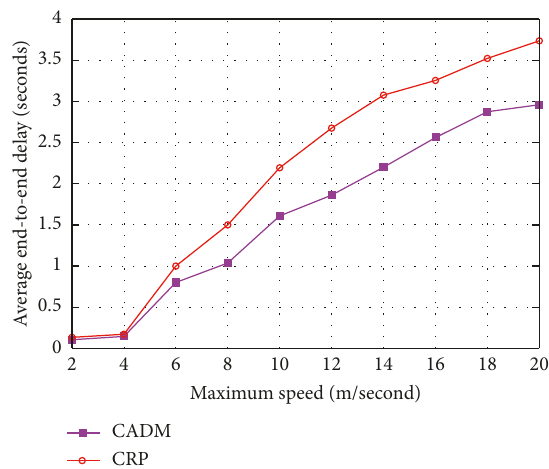
Figure 8: Packet delivery ratio (PDR) with varying nodes